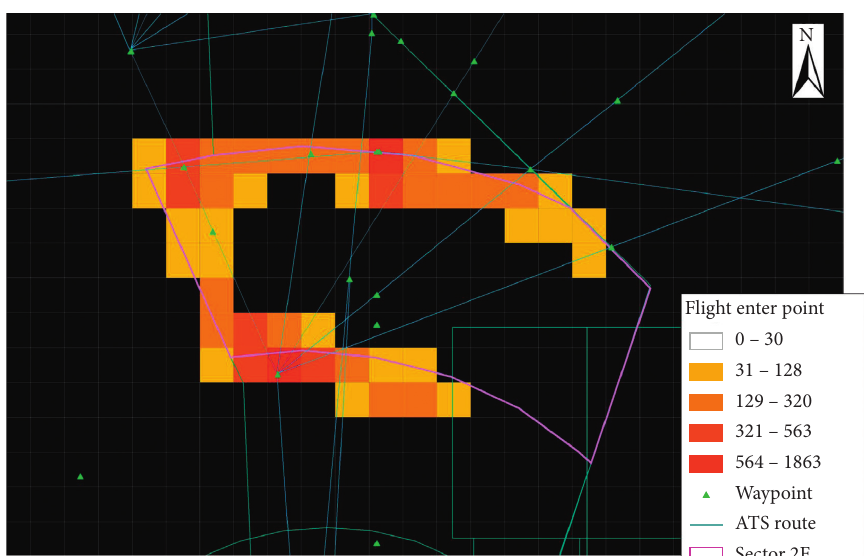
Figure 3: Distribution of entry points in sector 2E.